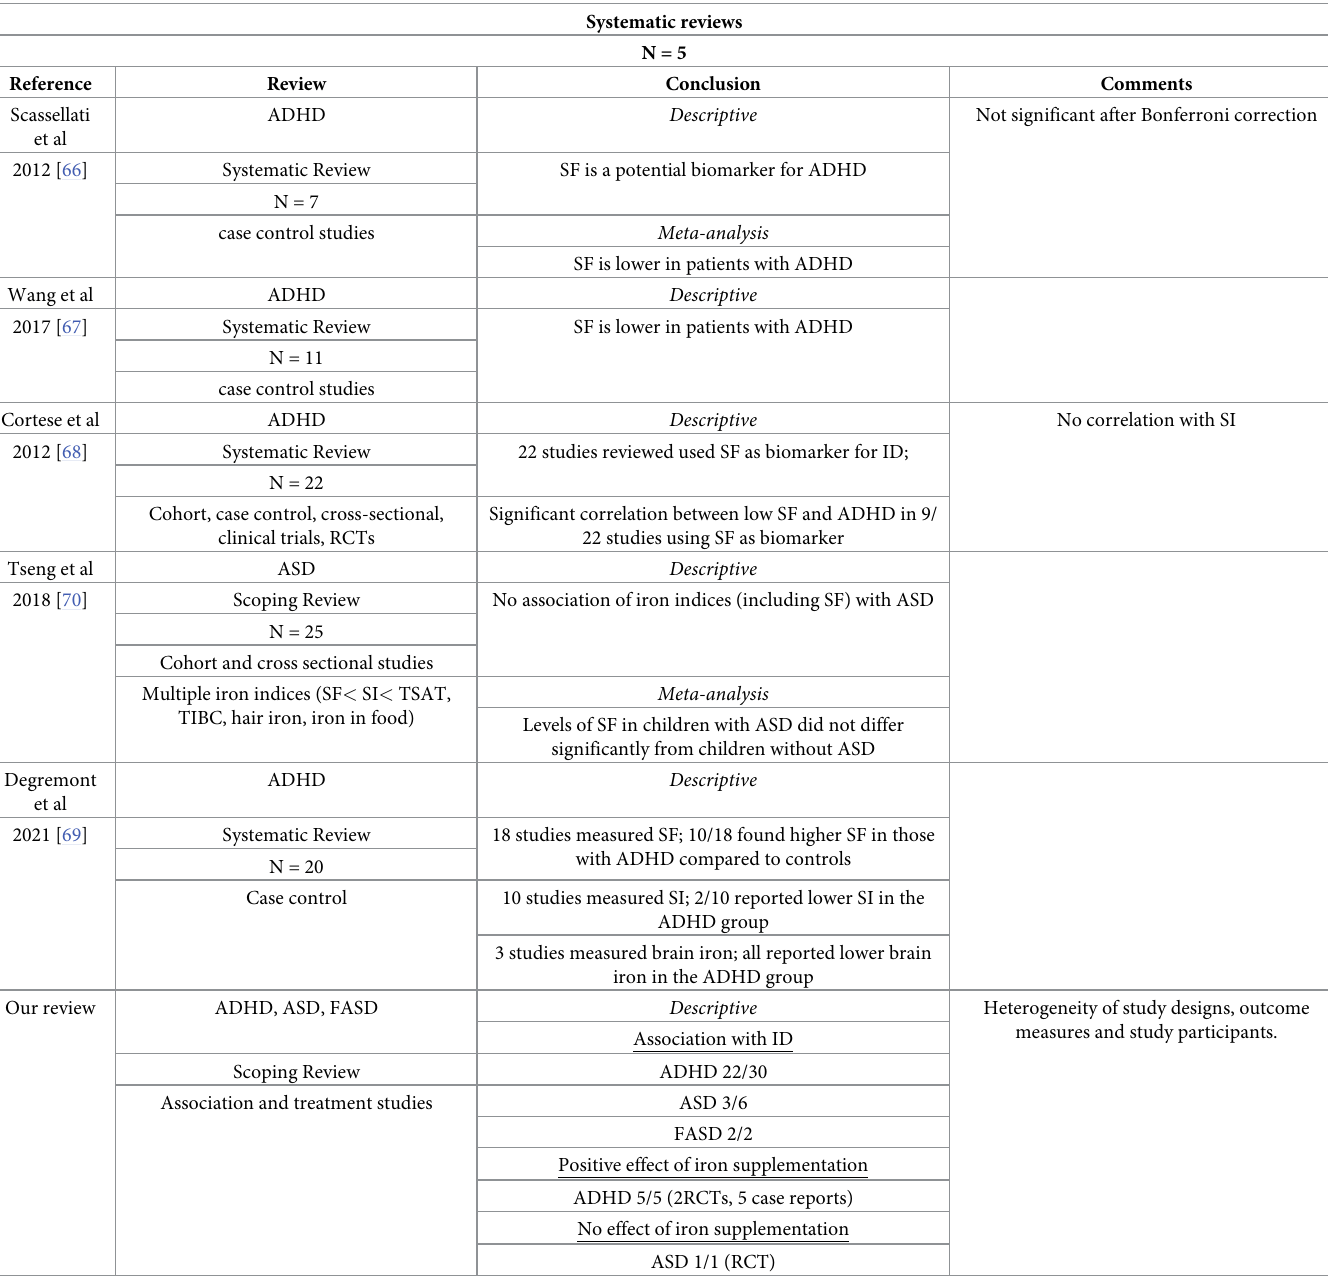
Table 3. Systematic literature reviews analyzing the role of iron deficiency in ADHD and